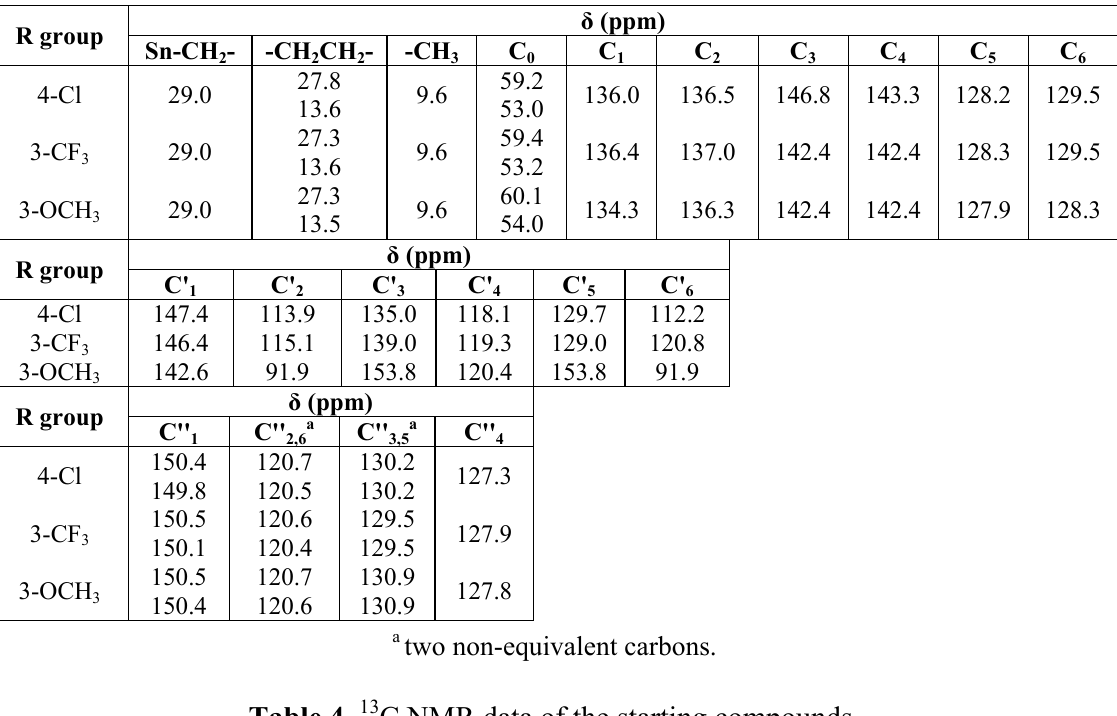
Table 3. 13 C-NMR data of the titled compounds.